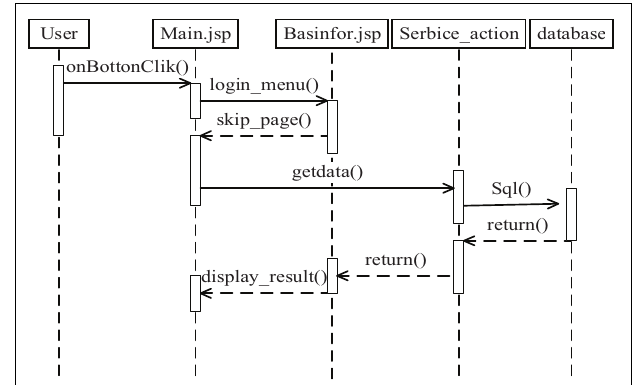
FIGURE 1 | Basic information management module.